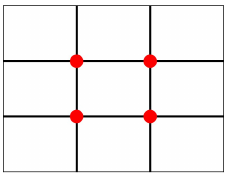
Figure 5. The lines and places (marked in red) where the rule of thirds considers.